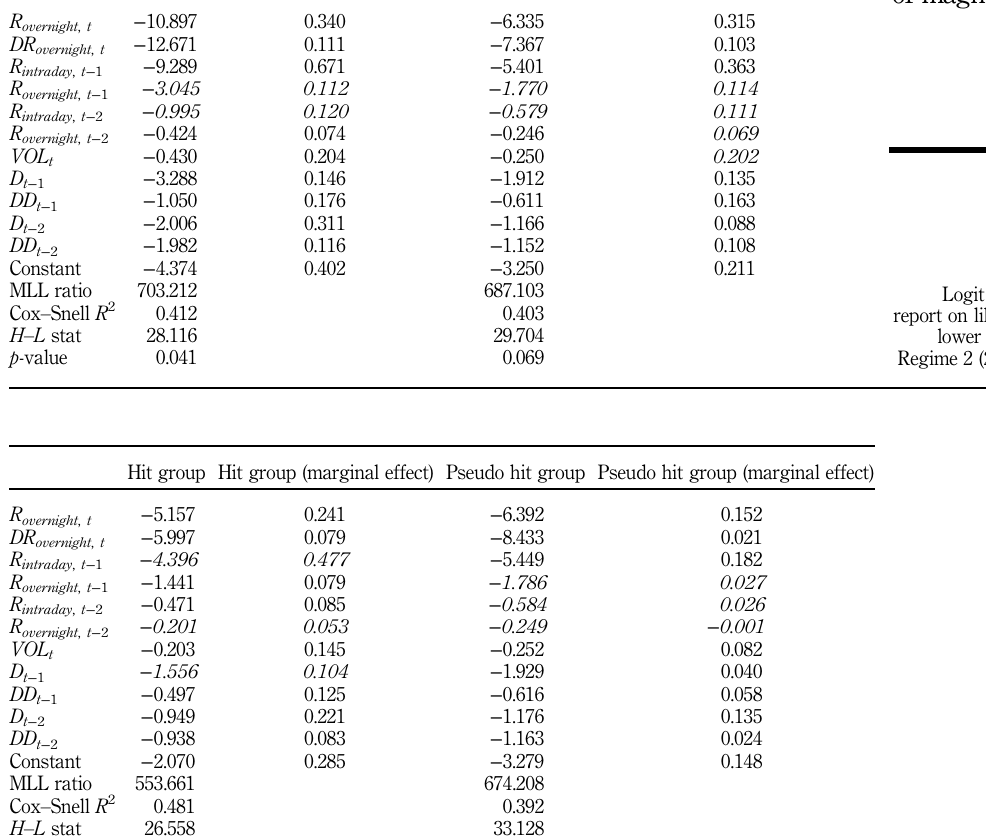
Table VI. Logit regression report on likelihood of floor hit in regime 3